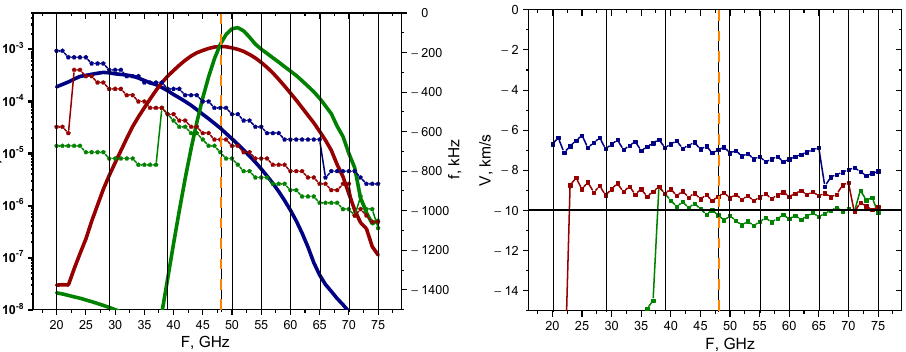
being lower in value.